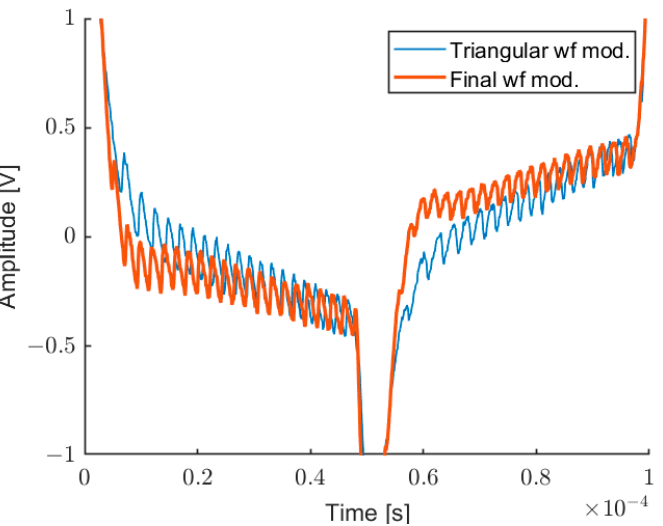
Figure 4. Interferometric signal before (thin line) and after (thick line) the linearity compensation.